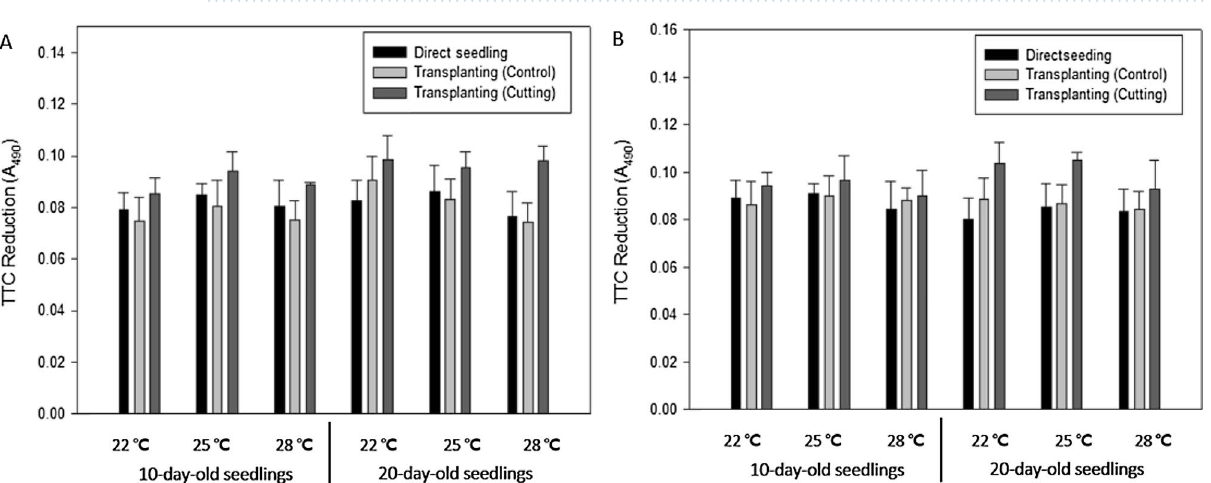
Figure 3. Difference in rice root activity (TTC reduction) in response to root cutting conditions, seedling age, and growth temperature. The analysis was conducted by sampling a total of seven times on days 1, 4, 7, 9, 11, 14, and 17 after transplanting and averaging the values for each day. ( A ) Odae, ( B ) Saenuri. Error bars are standard